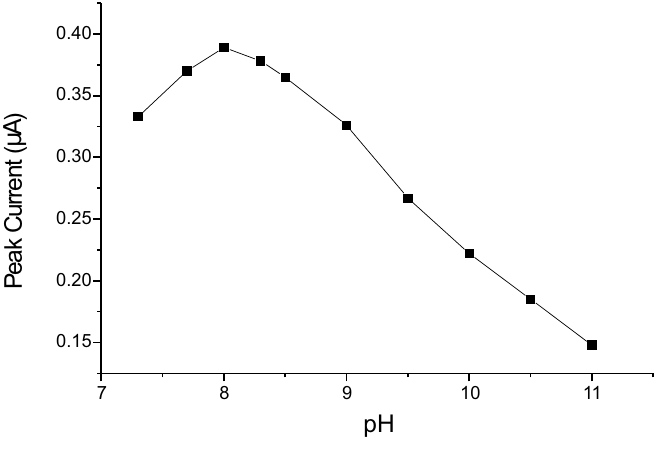
Fig. 2 – Cathodic Stripping voltammograms obtained for 1 . 0 × 10 − 6 mol L –1 of miconazole in B-R buffer pH 8.0. Accumulation potential (E ac ) = 0V, Scan rate = 100 mV s –1 , using accumulation time (t ac ) of: Curve A = 0s, curve B = 15s, curve C = 30s and curve D = 60s.